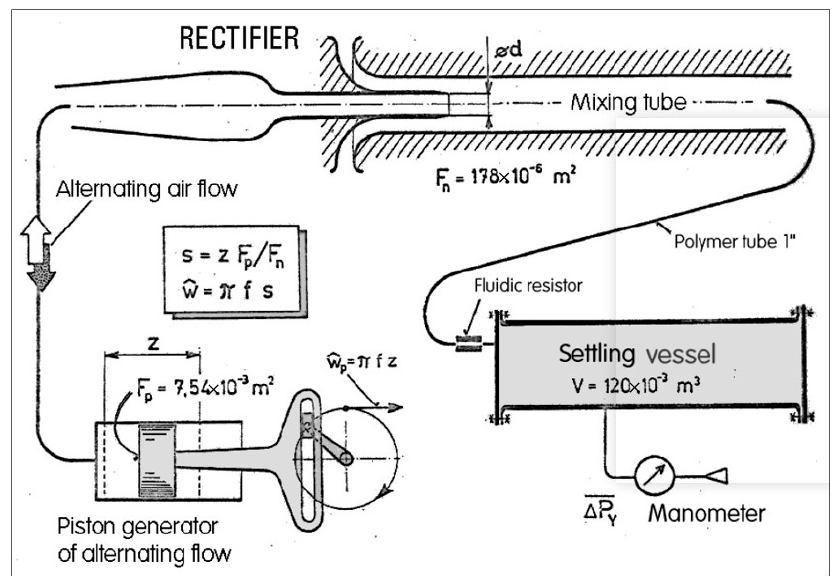
Figure 8. Schematic representation of the rectification experiment. The time-mean output flow from the mixing tube is zero. The pressure inside the settling vessel due to the rectification effect was measured by the manometer between the settling chamber and the atmosphere. The Scotch-yoke piston-type alternator generates a purely harmonic flow at adjustable frequency.